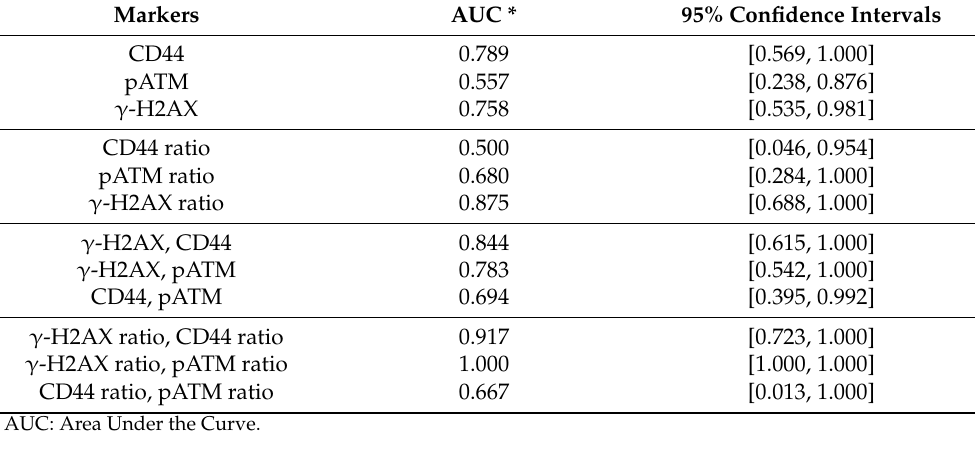
Table 2. Receiver Operating Characteristic (ROC) analyses for the different markers at basal levels (0 Gy) or after 4 Gy irradiation: 4 Gy/0 Gy ratio. Analyses were performed for all biomarkers individually or in combination.